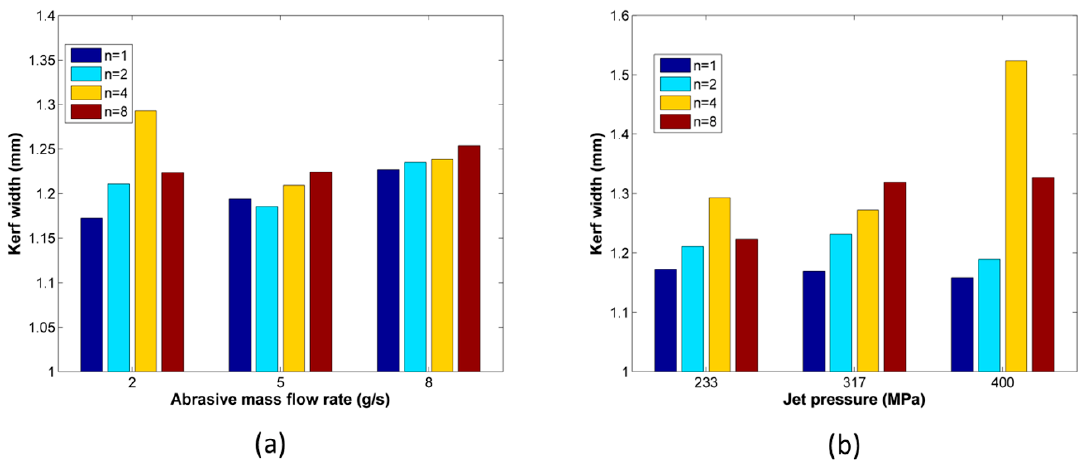
Figure 7. Variation of the top kerf width for increasing number of passes in respect to ( a ) abrasive mass flow rate and ( b ) jet pressure.